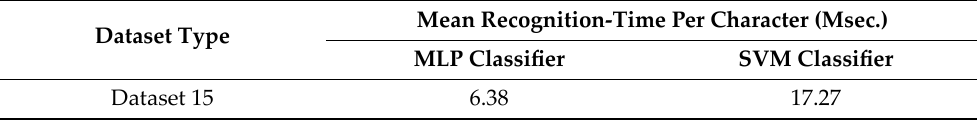
Table 14. Timing details related to character